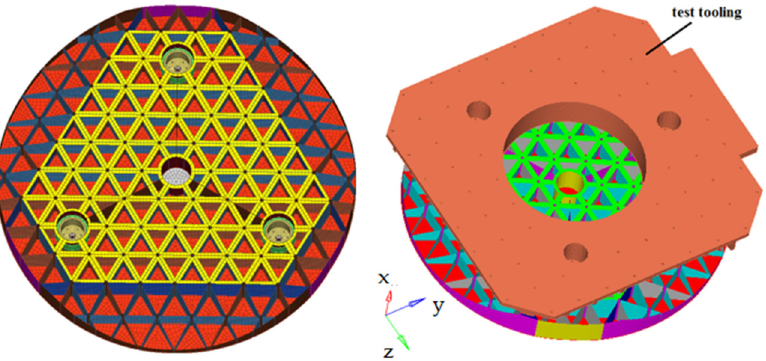
Figure 6. Finite element mode. Table 1. Mesh generation of mirror assembly.